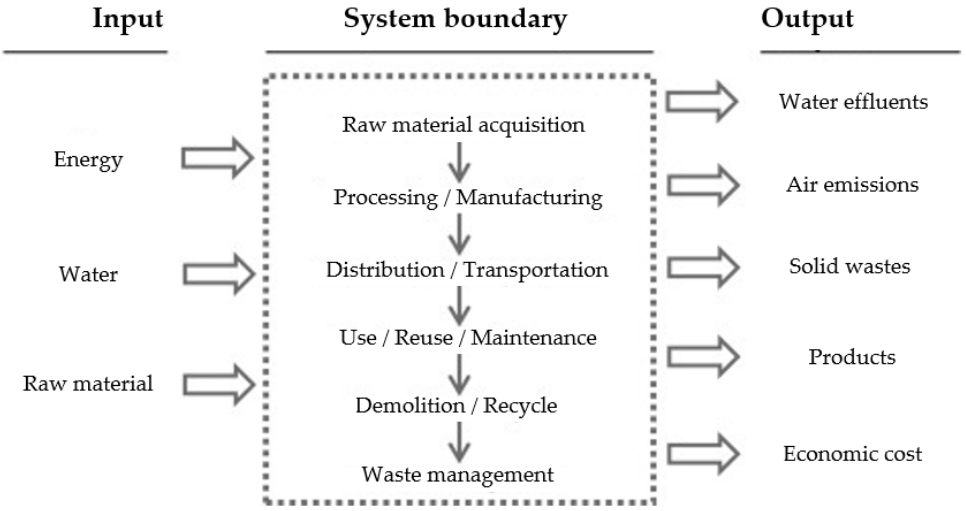
Figure 9. General framework of a system boundary for life cycle assessment (reproduced with permission from Hernandez et al. [146], published by Elsevier